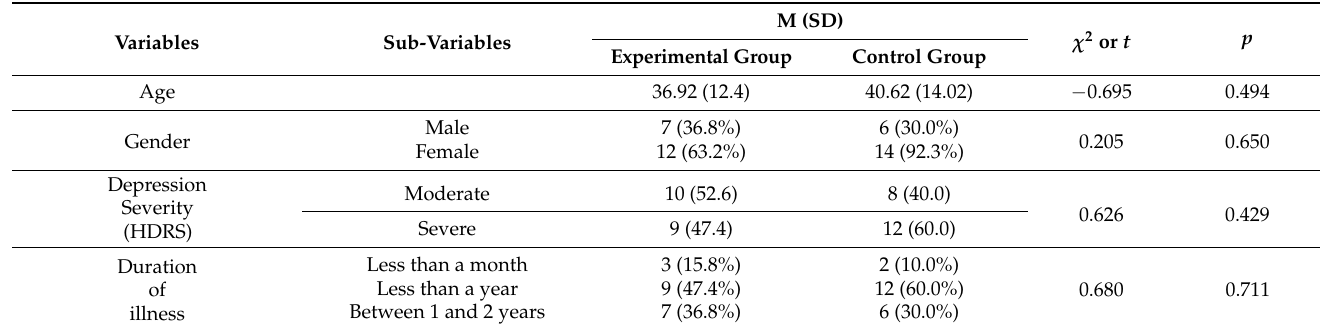
Table 1. Demographic characteristics of participants.